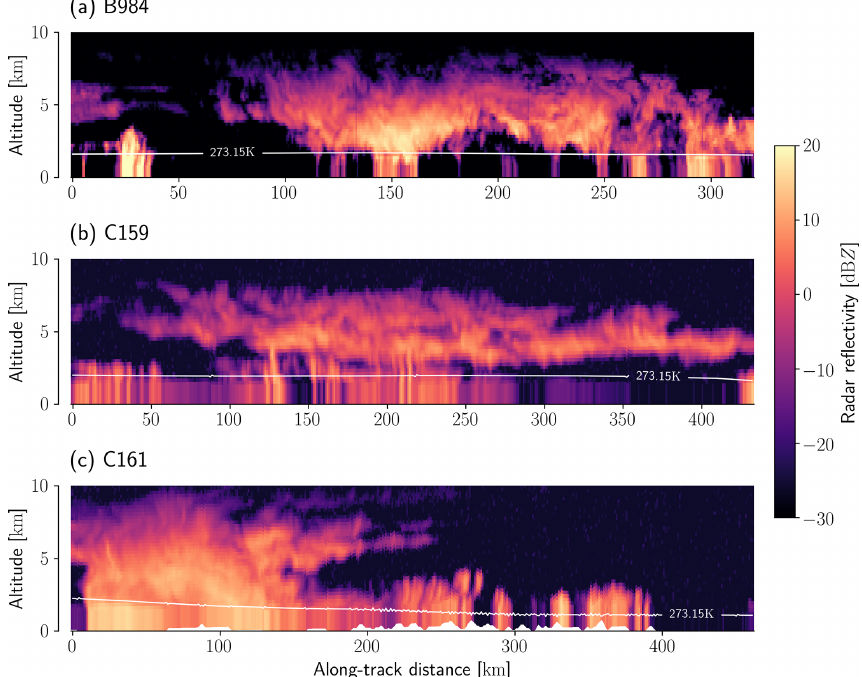
Figure 2. Radar observations from the flights used in this study. Panel (a) shows the radar reflectivity measured by the HAMP MIRA 35GHz cloud radar. Panels (b) and (c) show the reflectivity measured by the CloudSat CPR at 94GHz. The white line displays the ERA5 freezing level from Hersbach et al. (2018).